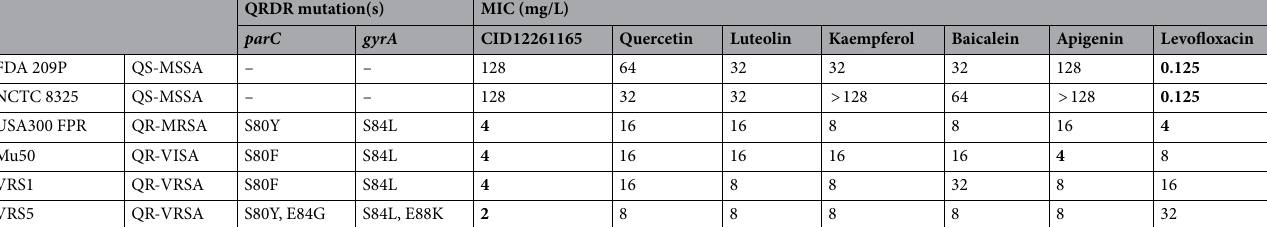
Table 1. Minimum inhibitory concentration of the tested flavonoids against S. aureus strains with various QRDR mutations. QS quinolone susceptible, QR quinolone resistant, MSSA methicillin-susceptible S. aureus ,